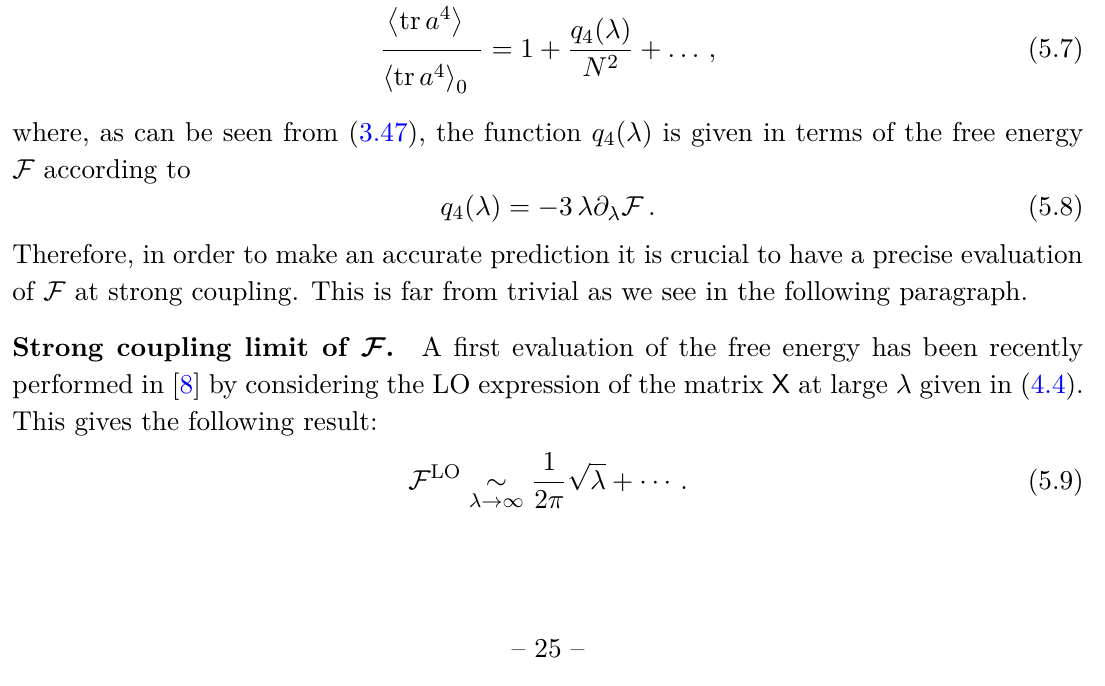
Figure 2 . Comparison between the Padé curve 1 + P 1 + P (∆ 2 ) (red curve) and the large λ theoretical predictions for γ 3 = 1 + ∆ 1 ( λ ) (blue dashed [70 / 70] curve) and γ 5 = 1 + ∆ 2 ( λ ) (black dashed